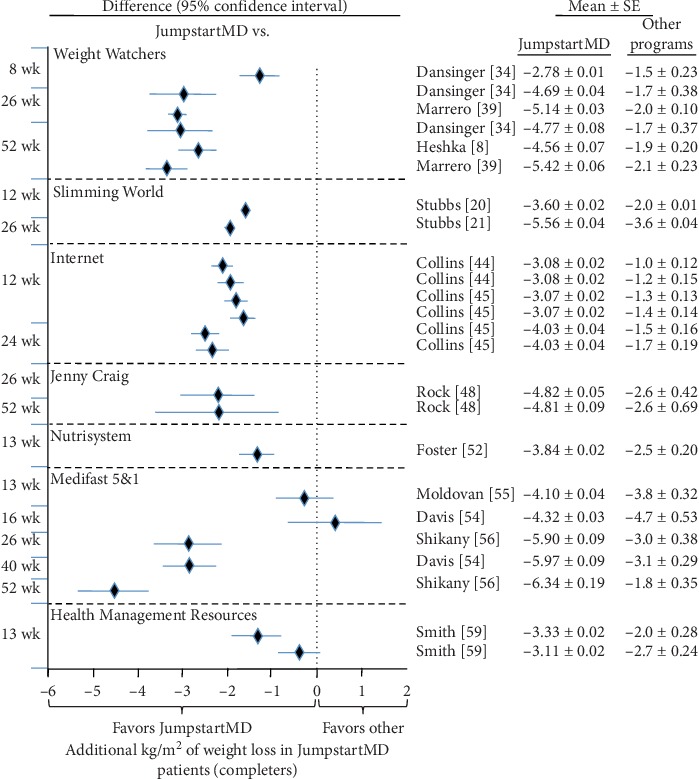
Mean weight loss difference between JumpstartMD and other commercial programs in completers as measured by ΔBMI. Negative differences designate greater JumpstartMD BMI loss. See legend to Figure 5 for further explanation.